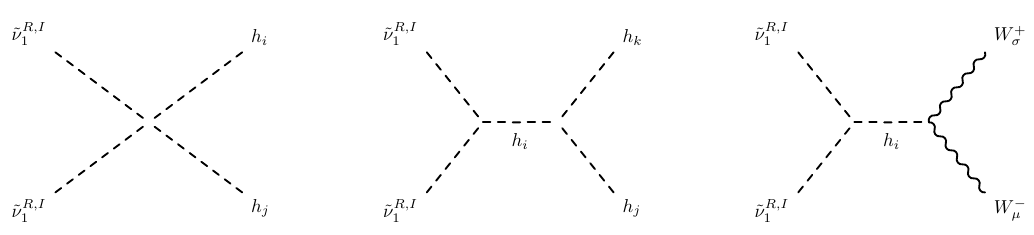
Figure 2 . Feynman diagrams of the dominant interaction terms of two real or two imaginary RH